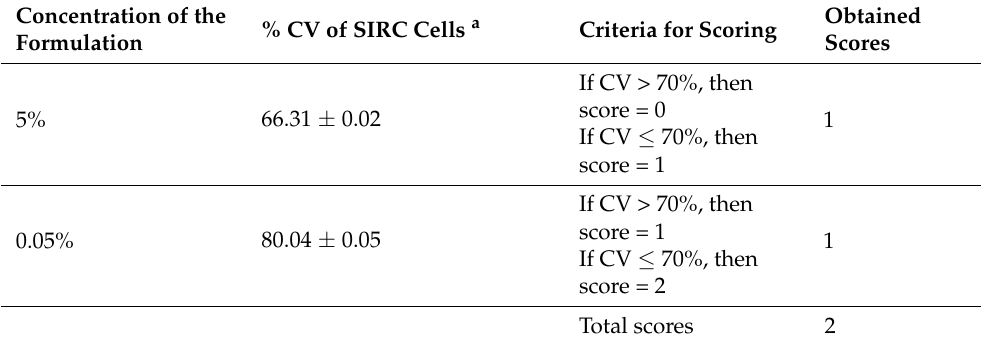
Table 6. Scores obtained from the STE test of F6.